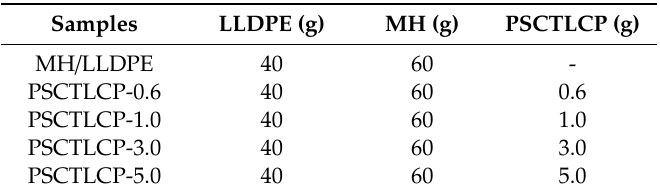
Table 1. Compositions and code names of the